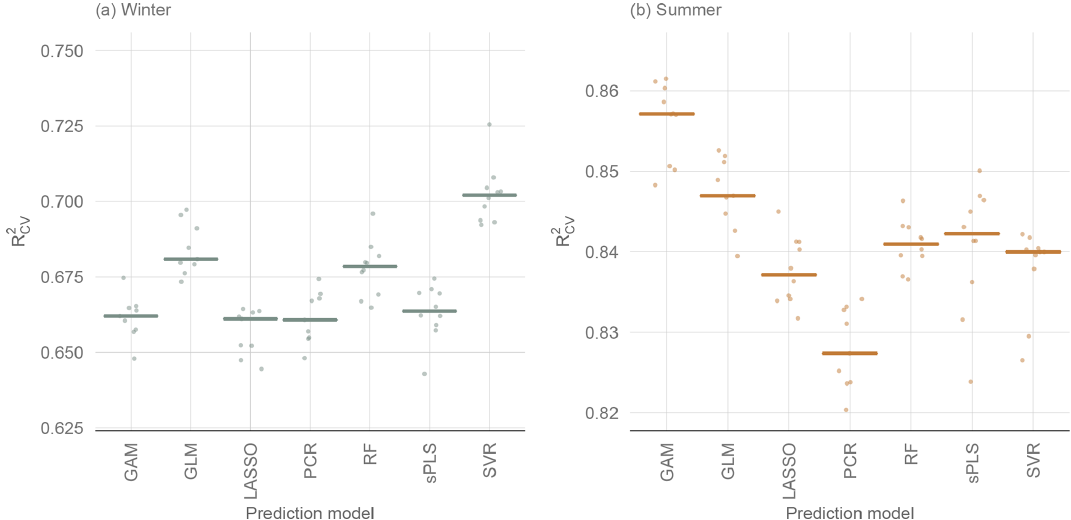
Figure 5. Performance of 10 CV runs of statistical learning models without variable preselection. Horizontal lines display the median of the CV